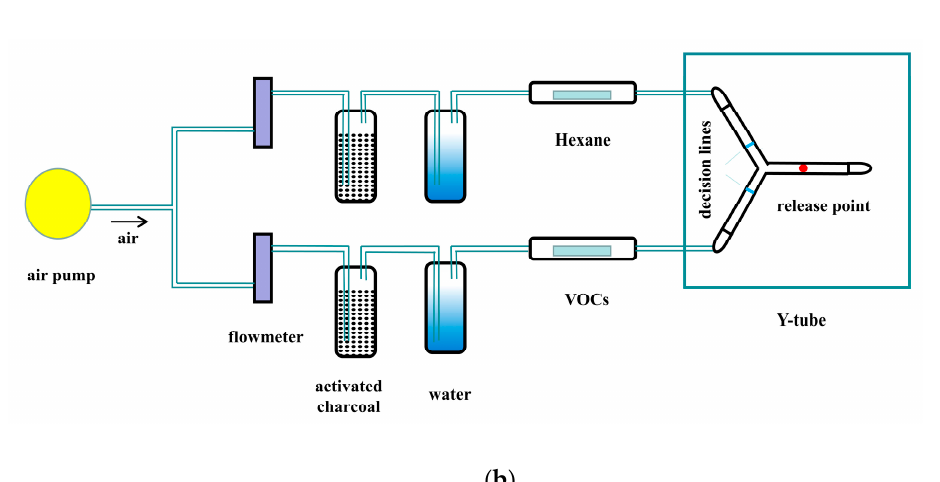
Figure 1. ( a , b ) Schematic diagram for Y-tube bioassay. ( a ) d17 mutant plants and WT plants used for pairwise comparison were placed into the two odor source bottles. ( b ) Hexane and VOCs used for pairwise comparison were placed into the two odor source bottles. Air was forced through the air pump, flowmeter, activated charcoal, water, odor source bottles and Y-tube in that order. The air was purified using active carbon and water, respectively. The air flow in each arm of the Y-tube was kept at 300 mL/min, and the host selection test was conducted in a dark case.